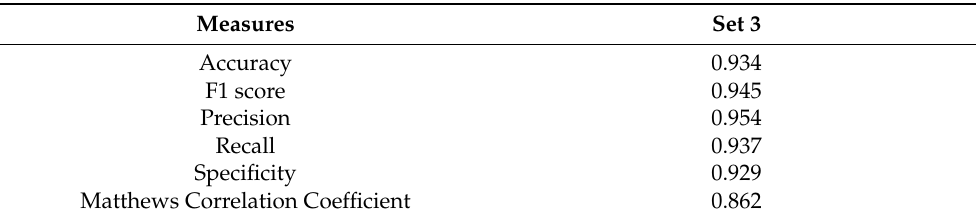
Table 7. Effectivity of the forward NN1 model for recognition of trolls learned on Set 3 (all attributes). The model was trained at 50